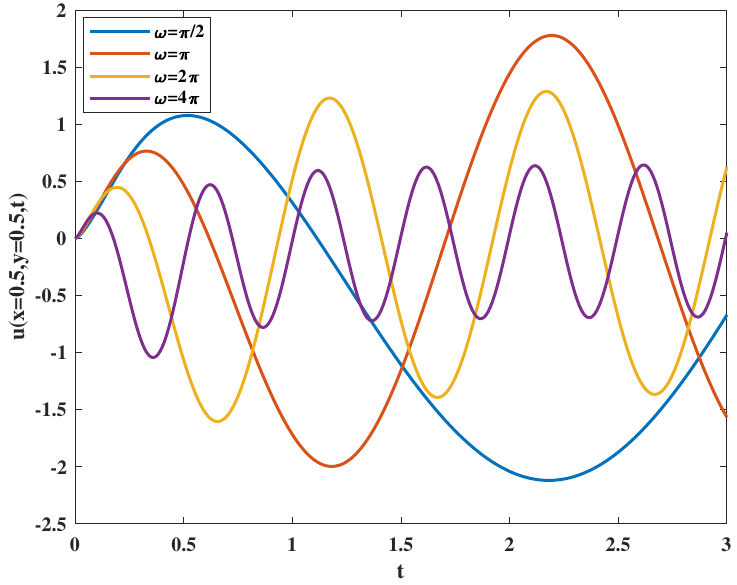
Figure 2. Velocity varies with period parameter of pressure gradient ω